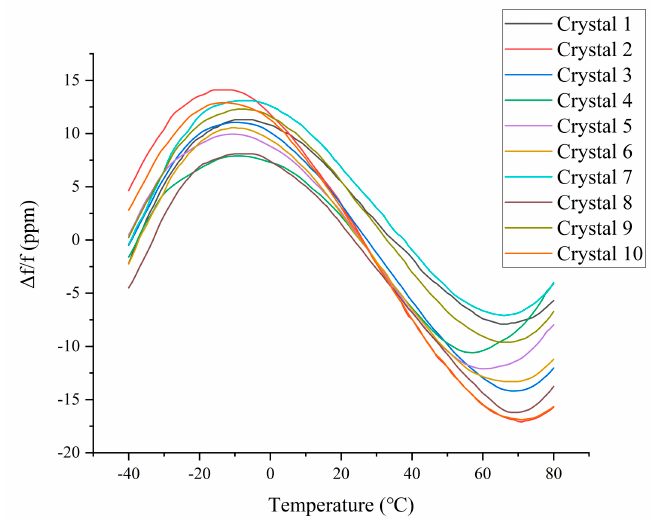
Figure 1. Crystal frequency–temperature diagram.